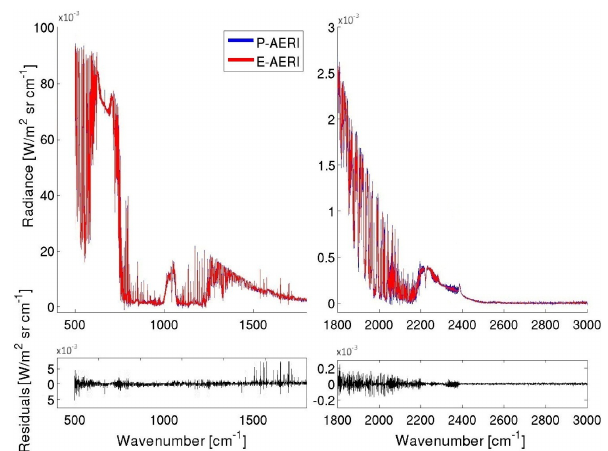
Fig. 5. Side-by-side comparisons between the E-AERI (red) and P-AERI (blue) instruments within the P-AERI spectral range on 20 October 2008. Top panels display measured radiance with resid- uals in the bottom